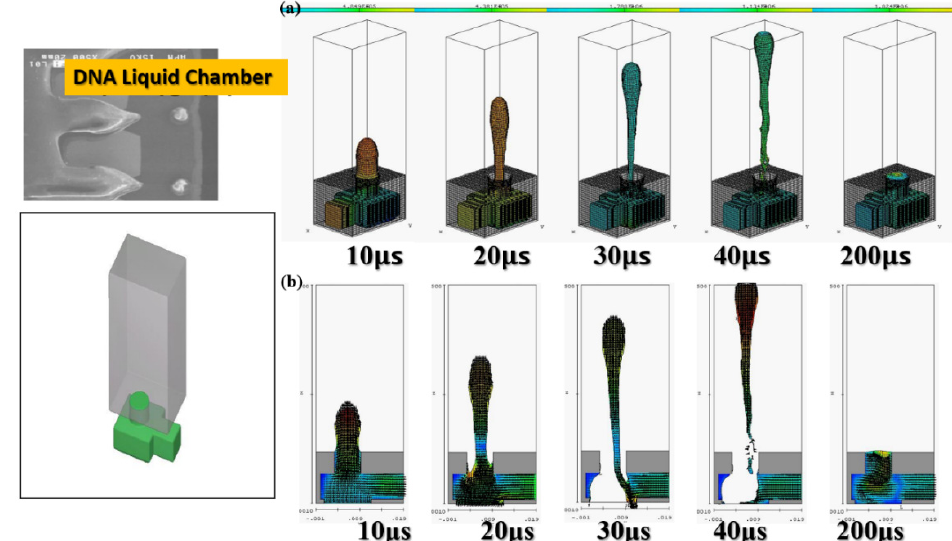
Figure 3. The geometry of the jet cavity. ( a ) The actual DNA liquid chamber, ( b ) the three-dimensional view of the microfluidic single channel. A single-channel jet cavity with 60 µ m diameter and 50 µ m thickness, with an operating frequency of 5 KHz, in ( a ) three-dimensional side view ( b ) X-Z two-dimensional cross-sectional view, at 10, 20, 30, 40 and 200 µ s injection conditions.